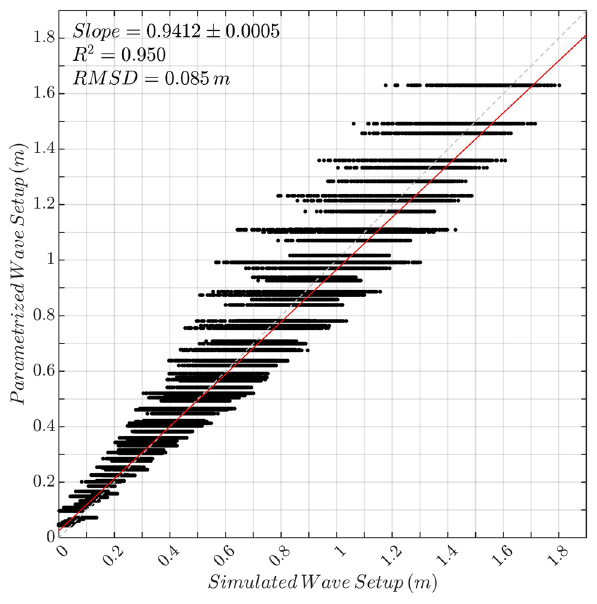
Figure 2. Parameterised wave setup computed using Eq. (1) vs modelled wave